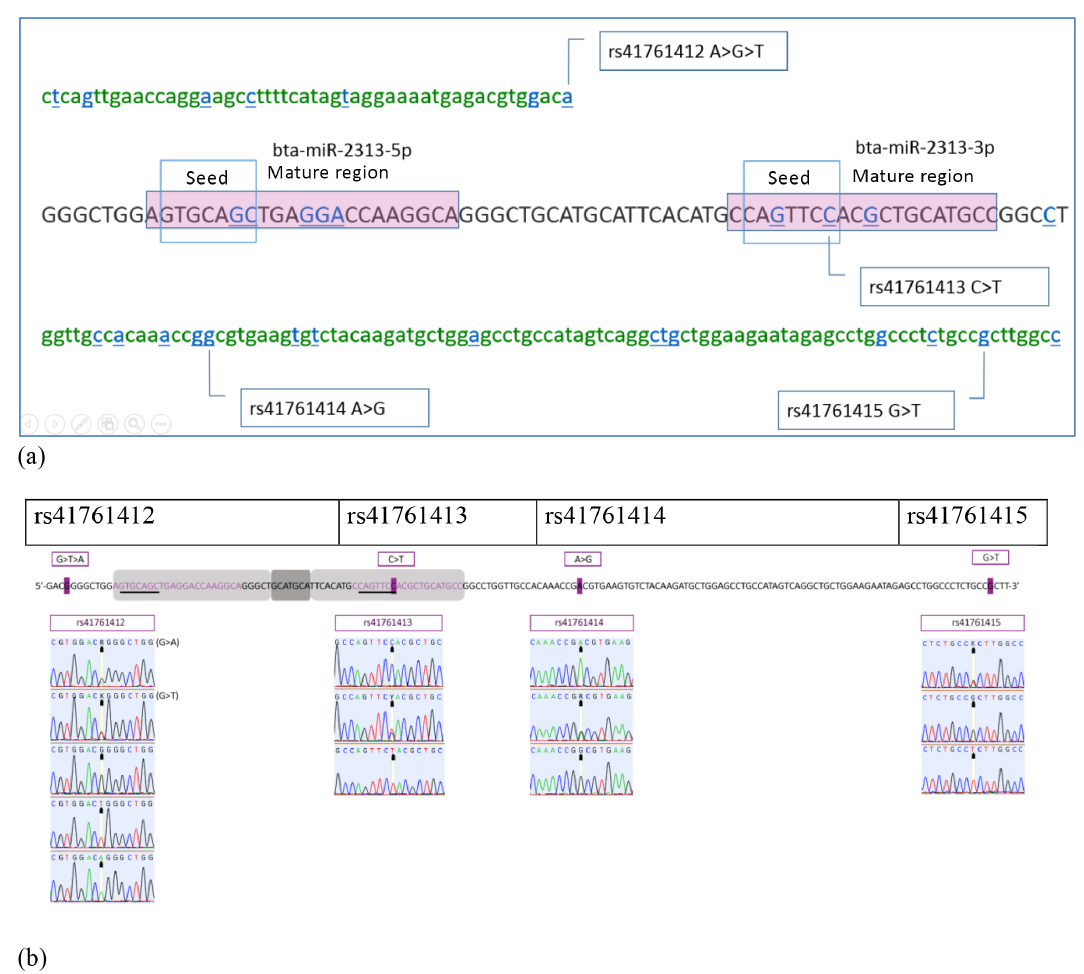
Figure 2. Genomic location and polymorphisms of the bta-mir-2313 gene in cattle. (a) bta-mir-2313 pre-miRNA sequence and flanking pri-miRNA sequence with polymorphisms extracted from the Ensembl database. The four polymorphisms validated in our tested population are marked in squares. (b) Experimental validation of polymorphisms rs41761413 located within the mature seed region and three additional SNPs within the pri-miRNA region (rs41761412, rs41761414, and rs41761415).